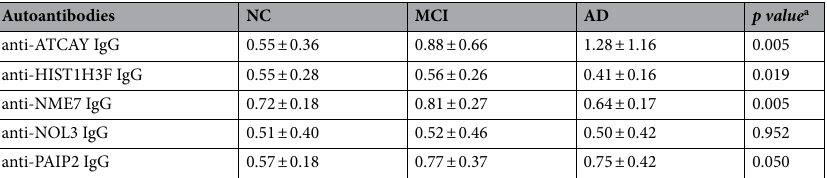
Table 1. Levels of autoantibodies in the AD, MCI and NC group. Data are shown as mean ± standard deviation (SD). a Significant differences were evaluated by Kruskal–Wallis test after removing outliers that were more than 1.5 × interquartile range (IQR) of autoantibody